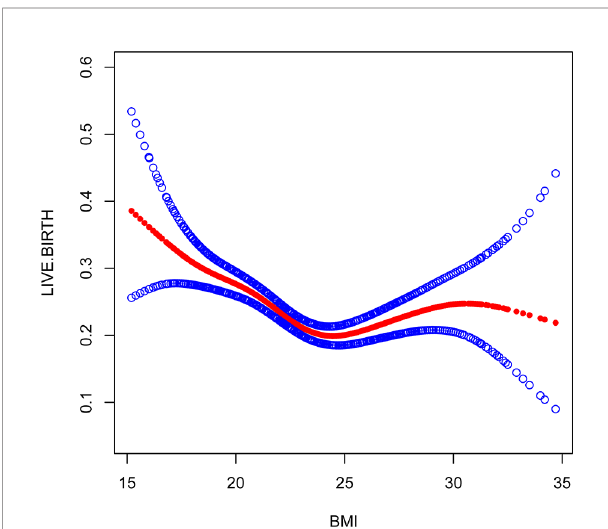
FIGURE 1 | Association between live birth and female age. A threshold, nonlinear association between live birth and these independent predictive factors was found in a generalized additive model (GAM). Solid rad line represents the smooth curve fi t between variables. Blue bands represent the 95% of con fi dence interval from the fi t.